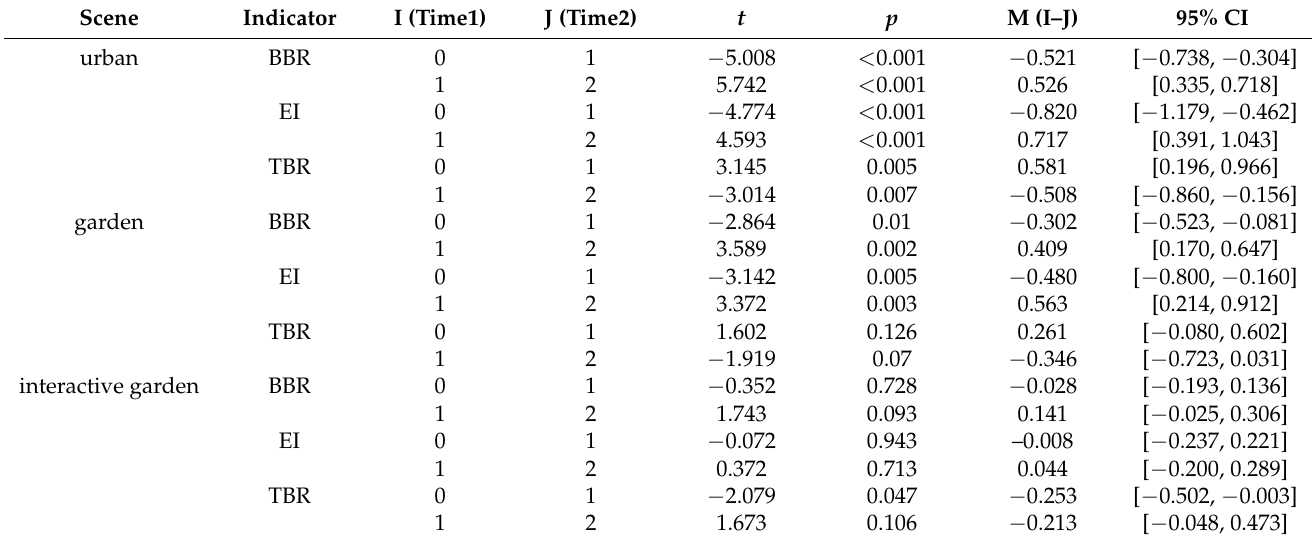
Table A10. Post-test results.